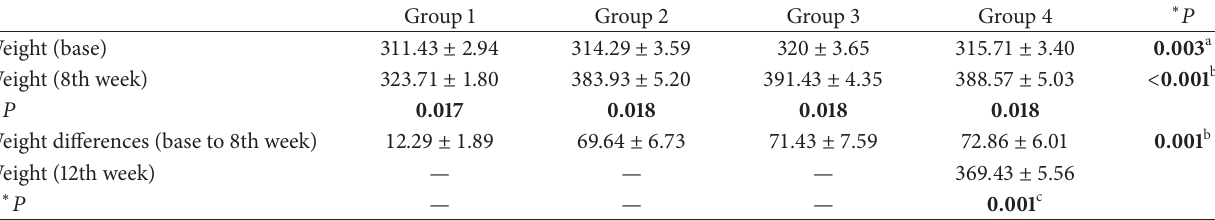
Table 1: Weights of rats at the beginning and at the end of